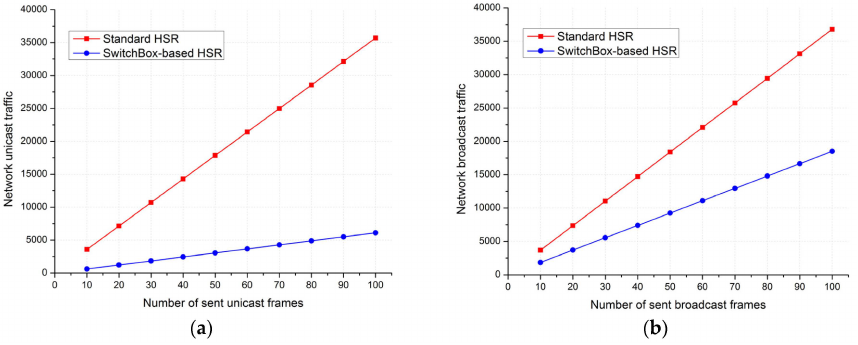
Figure 28. Comparison of the network traffic performance between the standard HSR and the SwitchBox-based HSR in case 1 of Simulation 3. ( a ) Unicast traffic; ( b ) Broadcast traffic.